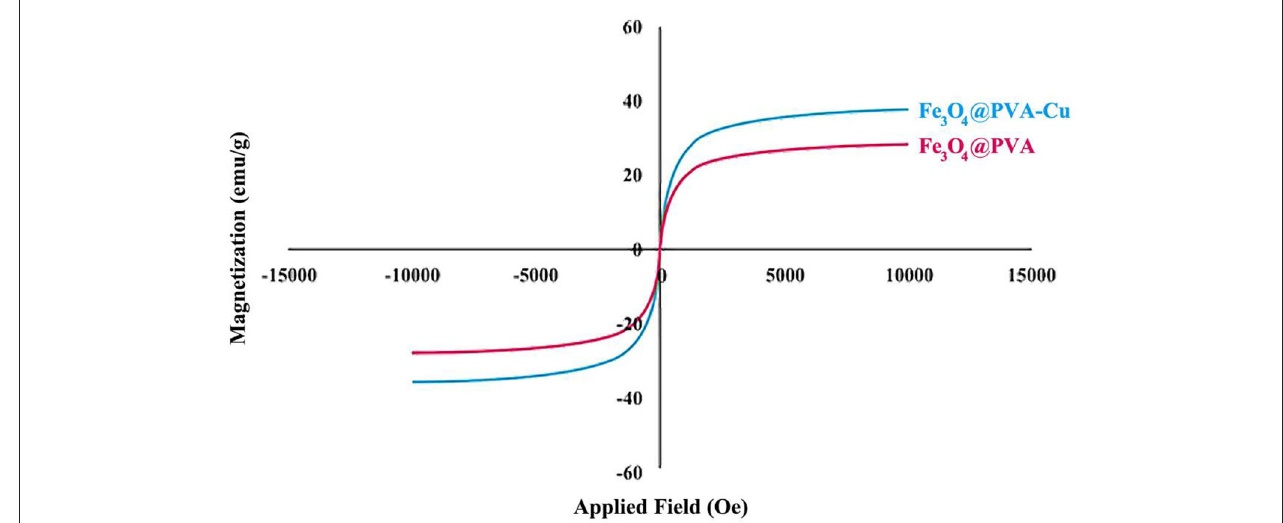
FIGURE 4 | VSM graph of Fe 3 O 4 @PVA and Fe 3 O 4 @PVA-Cu nanoparticles at room temperature.